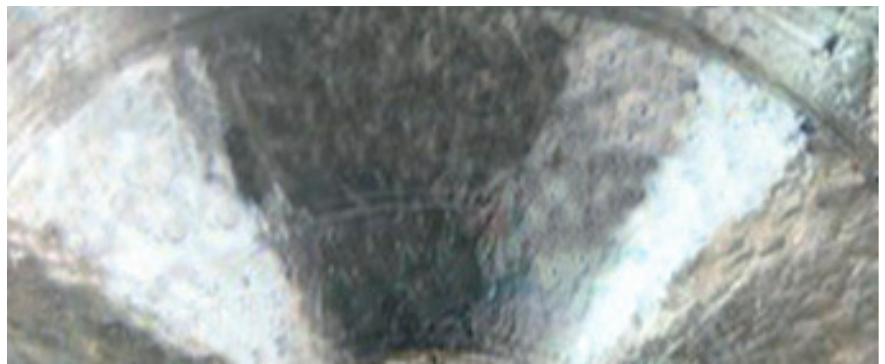
Figure 4. ‘Orange peel’ effect of turbocharger operation in overspeed conditions—zoomed surface of the rear side of the inducer (modified from Diesel Levante, 2017).